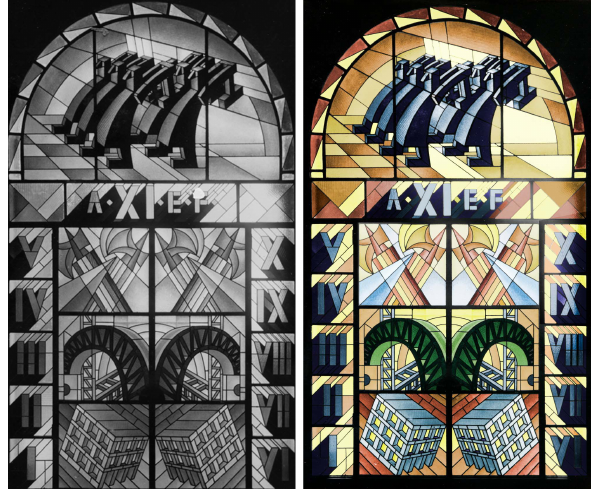
Figure 10. The Post office, Trento: color rendition (re- colouring) of stained glass windows designed by Fortunato Depero (authors: Fabrizio Broch, Irene Cartolari) The extrapolation of geometric information required